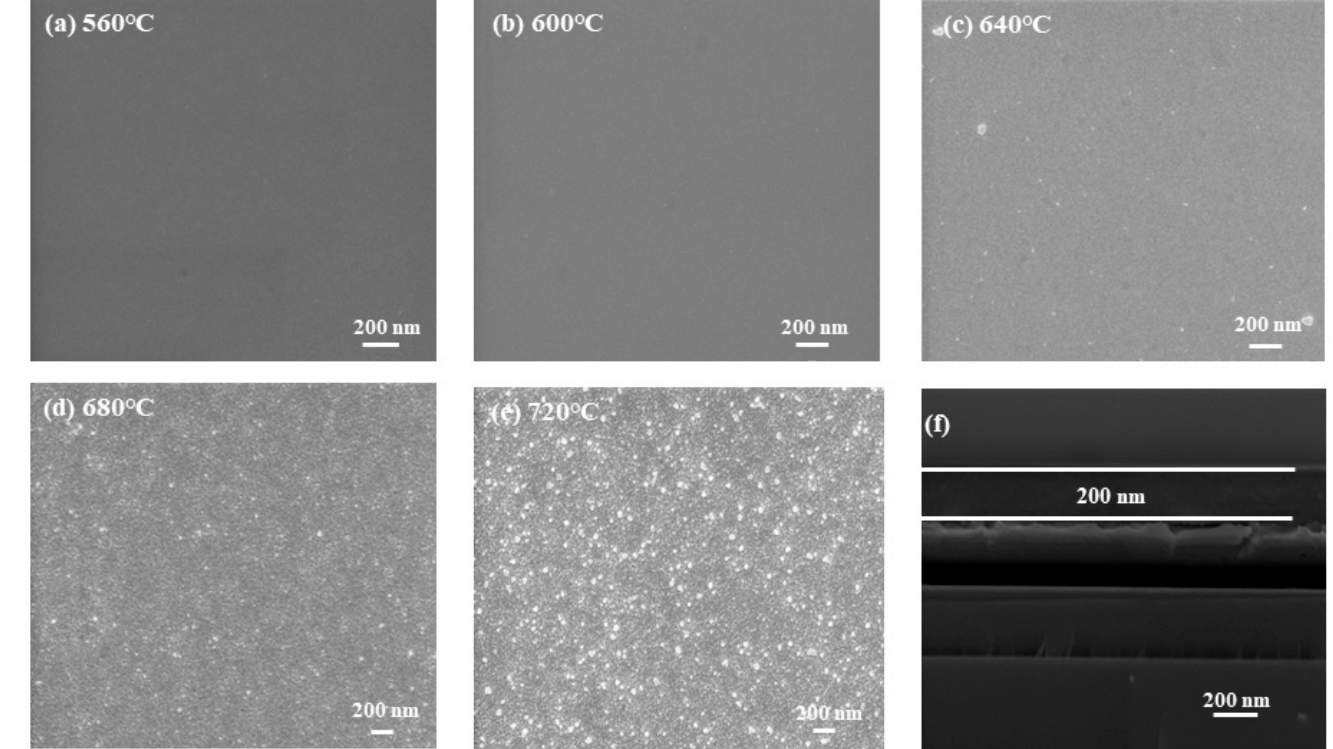
Figure 2. SEM micrographs of BT-8%Mn at different annealing temperatures: ( a ) 560 °C; ( b ) 600 °C; ( c ) 640 °C; ( d ) 680 °C; ( e ) 720 °C; ( f ) 640 °C annealed section scan.